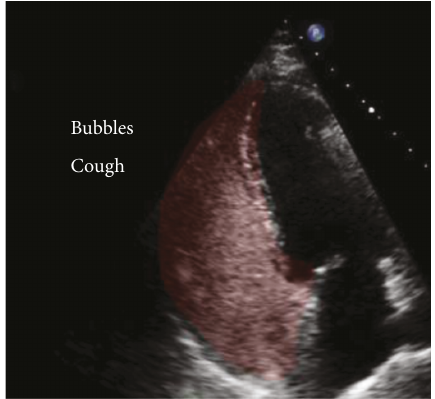
Figure 3: Agitated saline (highlighted in red) in the right heart revealing no crossover into the left heart consistent with no intracardiac shunts.